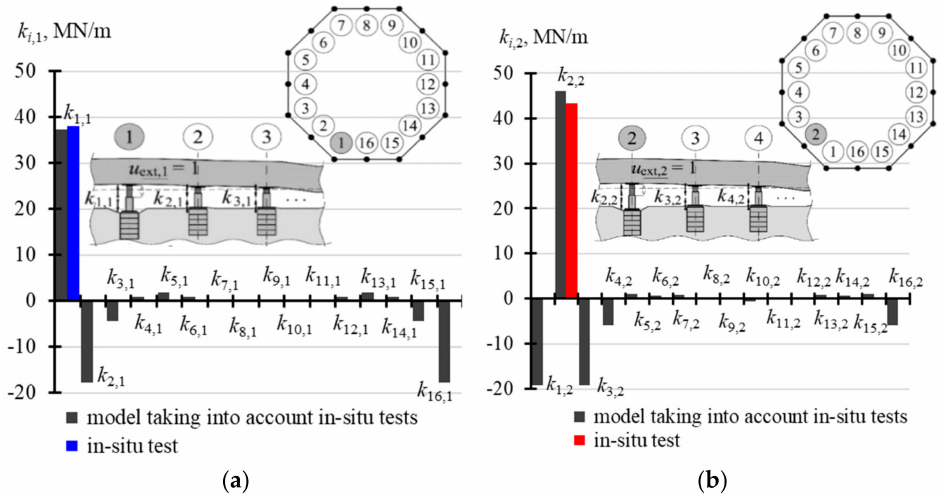
Figure 12. Values of elements in the matrix k : ( a ) elements k i ,1 ; ( b ) elements k i ,2 .